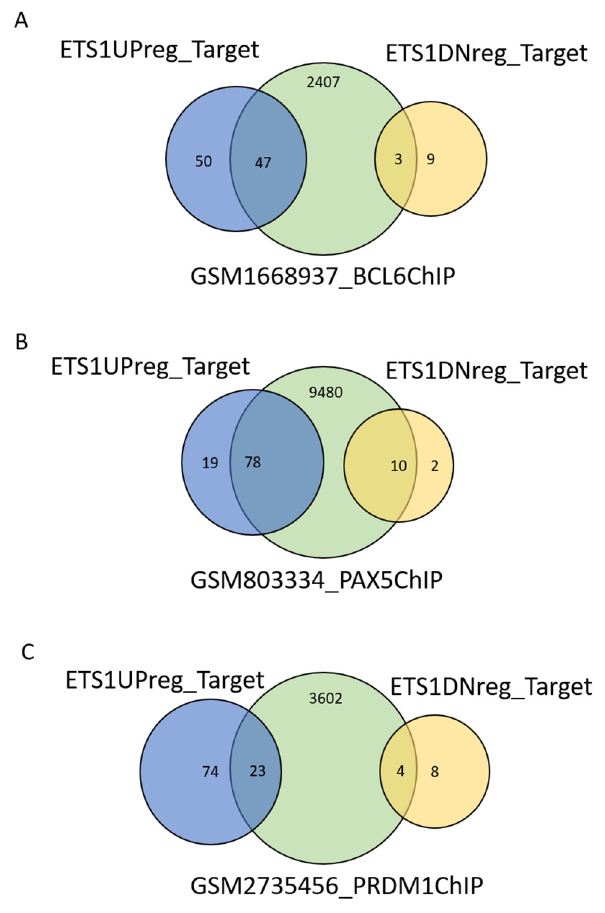
Figure 3. Overlap of ETS1-modulated genes with publicly available ChIP-Seq data for transcription factors important for B lymphocyte development and survival. Putative gene targets from public ChIP-Seq datasets for ( A ) BCL6, ( B ) PAX5, and ( C ) PRDM1 / BLIMP1 were downloaded from the Cistrome database and overlapped with genes that we identified as modulated by ETS1 knockdown in TMD8 and U2932 ABC-DLBCL cell lines.